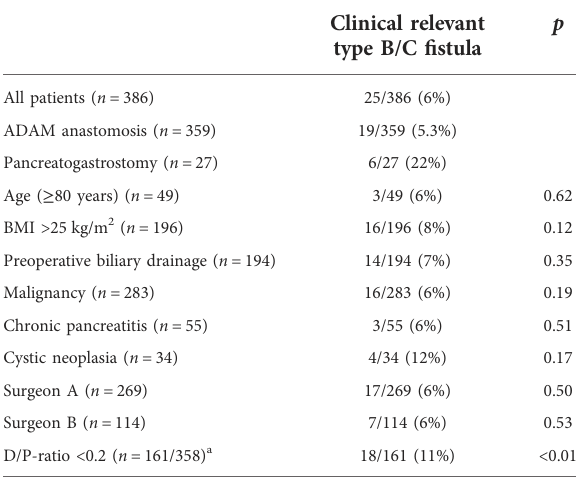
TABLE 1 Univariate analyses of factors related to clinically relevant postoperative pancreatic fi stula type B/C.